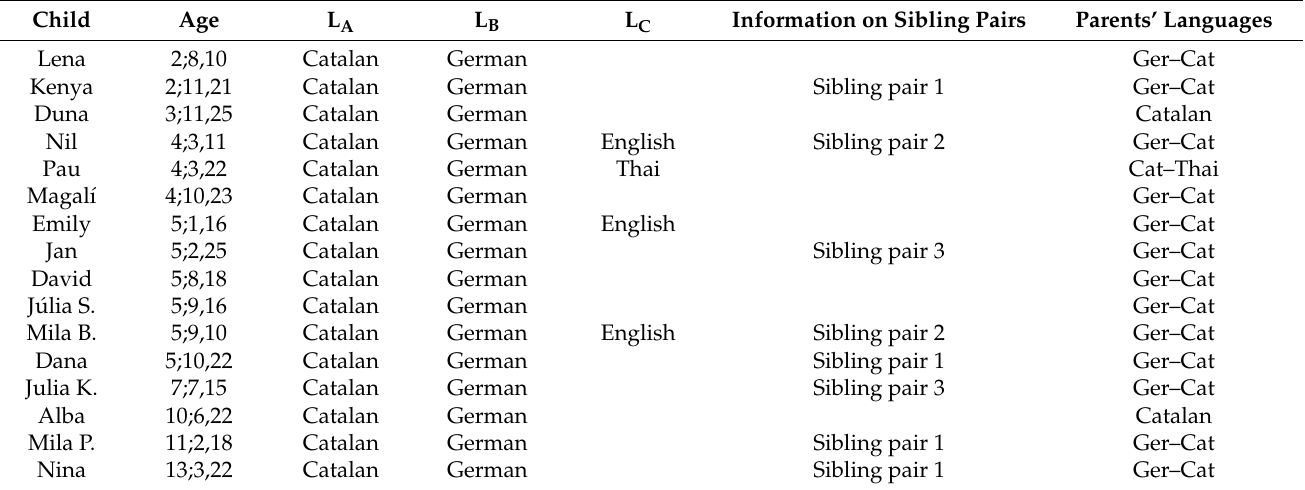
Table 1. Children according to age, L1s and information on sibling